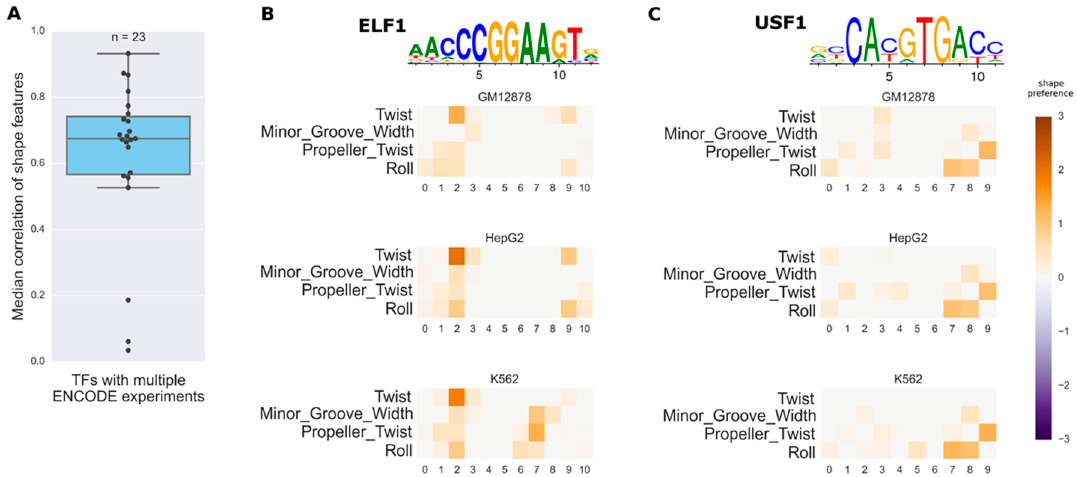
Figure 3. Shape model parameters in different conditions. ( A ) Distribution of median correlation coefficients for 23 TFs with multiple ChIP-seq datasets; ( B ) Shape feature preferences for ELF1 in three cell lines. The heatmaps show the preference for each shape feature at each position (the inferred d f matrix). Only the positive preferences are shown, that is, the preferences towards higher values of shape features. Colors faded to grey mean weaker preference; ( C ) Shape feature preferences for USF1 in three cell lines. The PWM logos are shown above the predicted shape preference heatmaps.